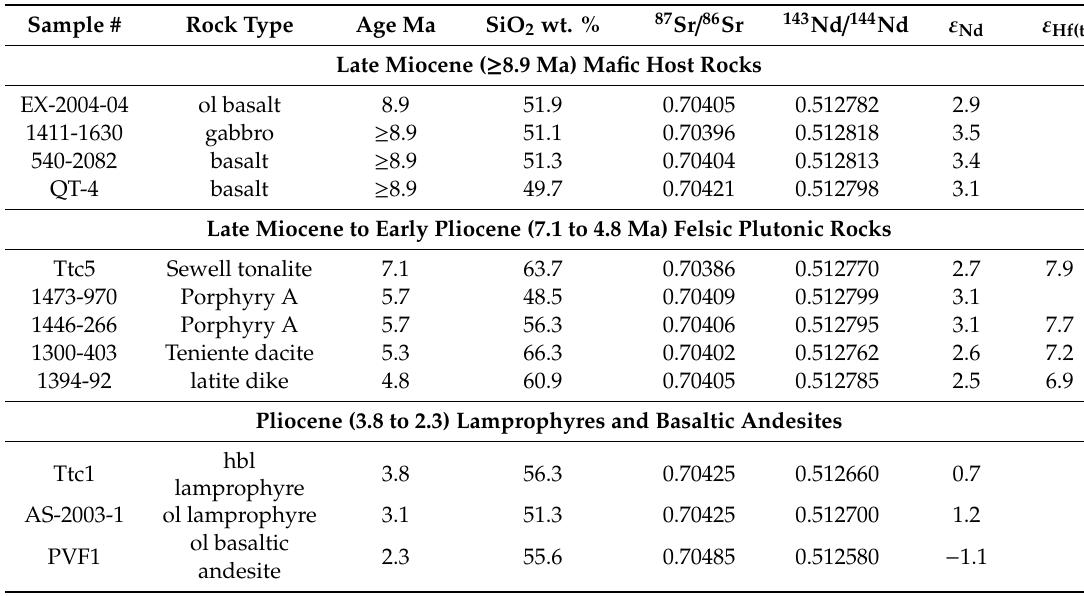
Table 1. Samples analyzed. Rock types, SiO 2 , 87 Sr / 86 Sr, 143 Nd / 144 Nd, and ε Nd from [21–23]. ε Hf(t) from